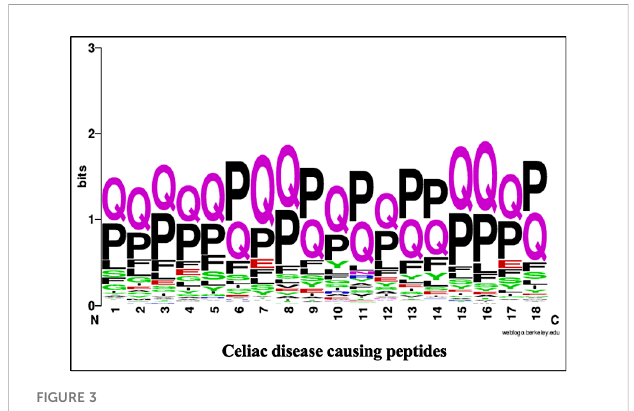
FIGURE 3 WebLogo of celiac disease-causing peptides.